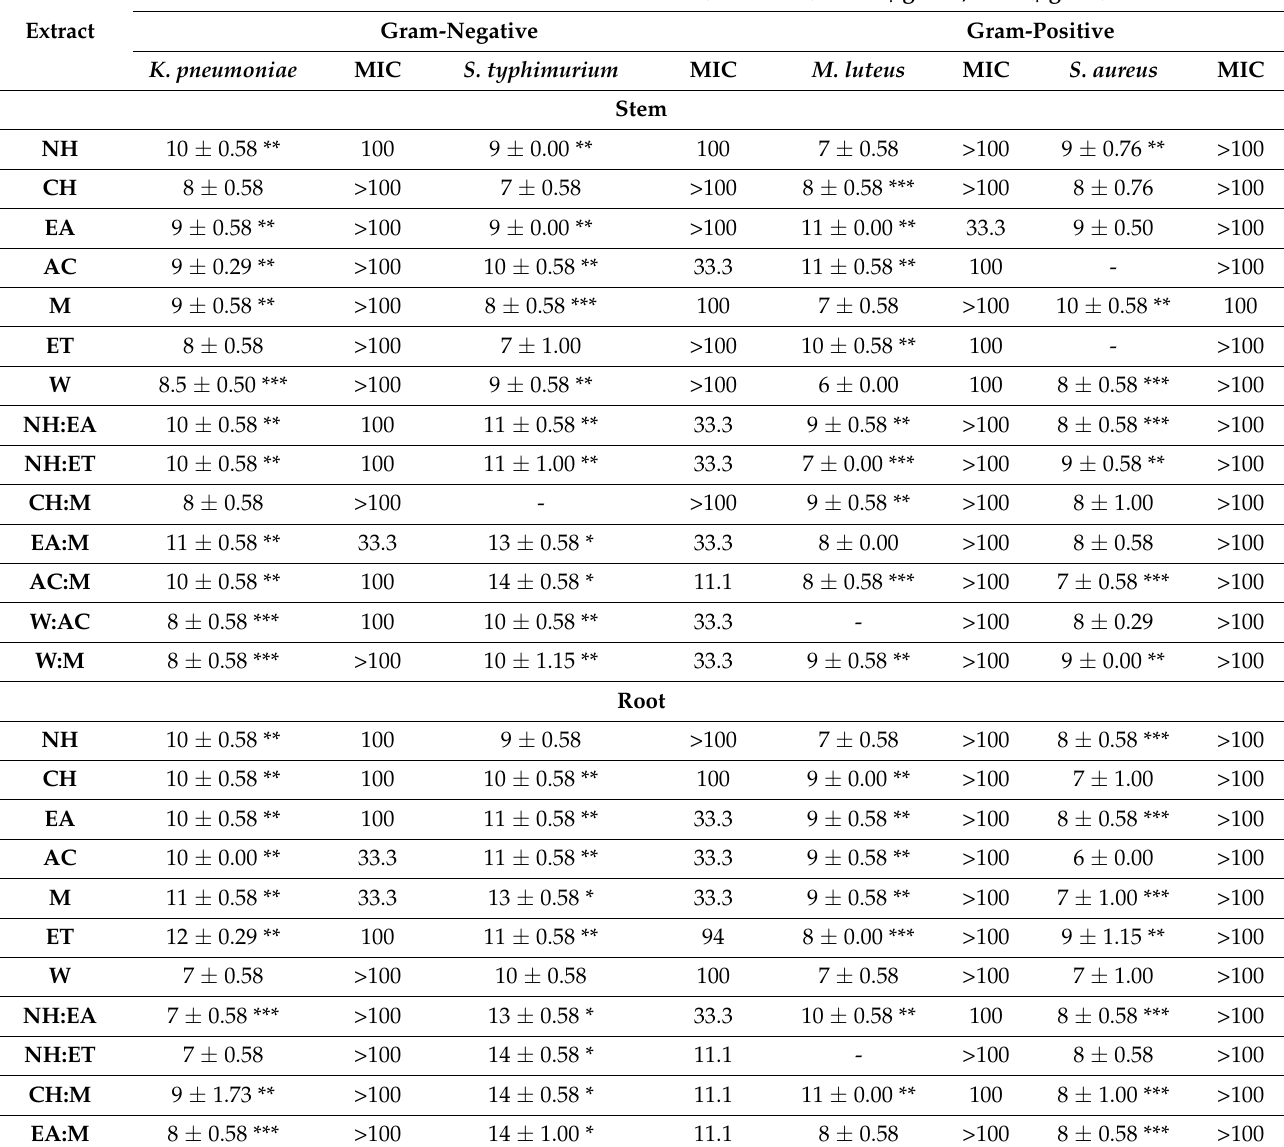
Table 3. Results of antibacterial activity of different solvent extracts of stem, root, seeds, and leaves of P. glabrum